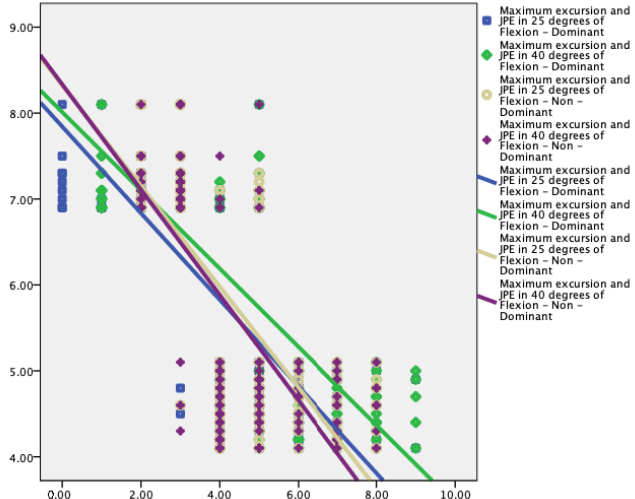
Figure 6. Relationship between maximum excursion (%) and knee joint position error at 25° and 40° flexion in dominant and nondominant legs.